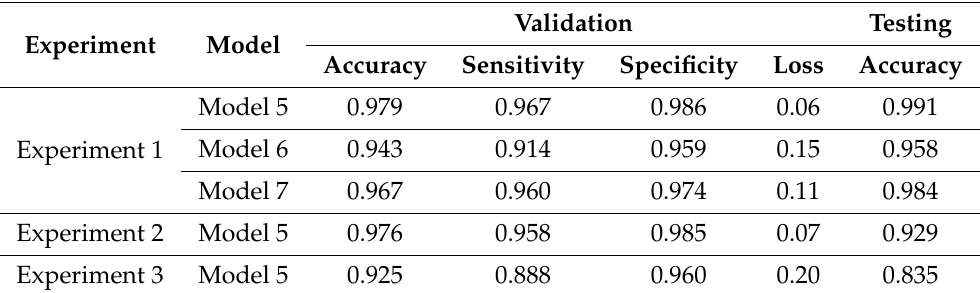
Table 2. Results of the selected models in each experiment. Metrics of the validation and testing phases are averages over five